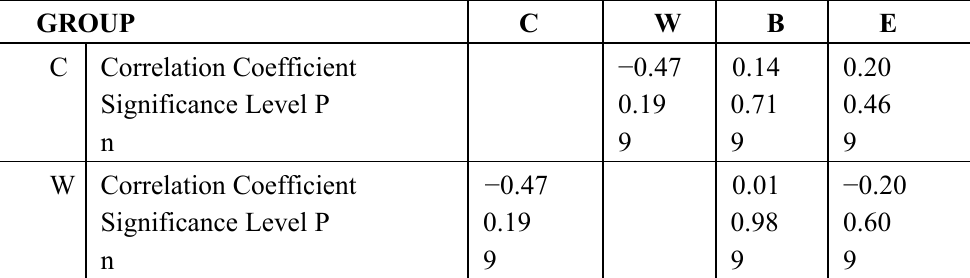
Table 2. Pearson correlation coefficients between the average values of minimum current strength for different